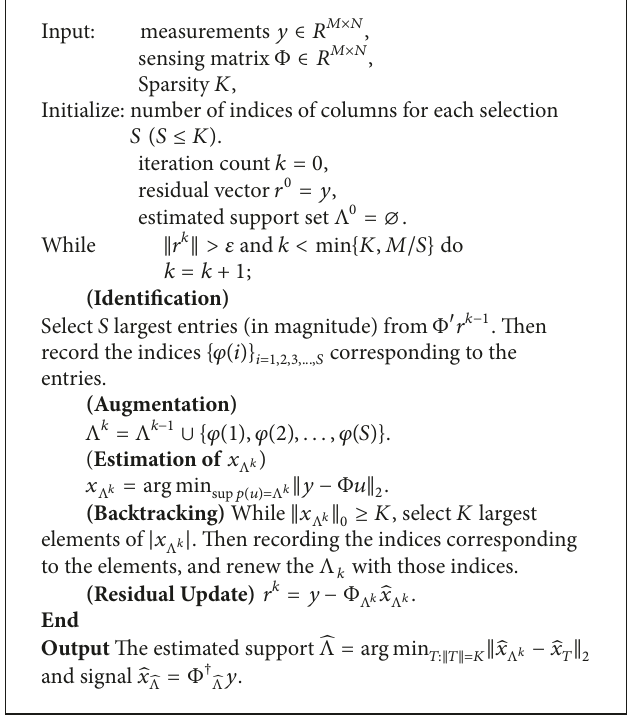
Algorithm 2: Improved method of GOMP.